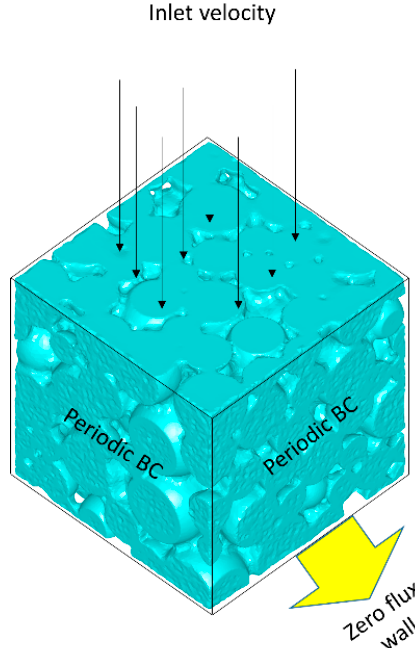
Figure 2. Computational domain and boundary conditions.